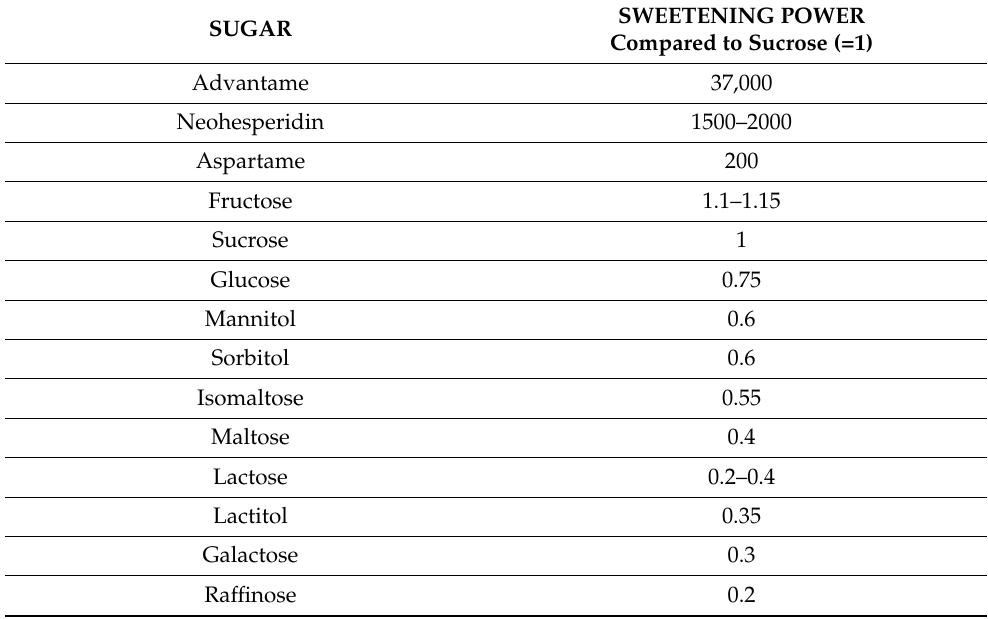
Table 3. Main sugars and their sweetening power compared to sucrose, modified from [42]. SWEETENING POWER SUGAR Compared to Sucrose (=1) Advantame 37,000 Neohesperidin